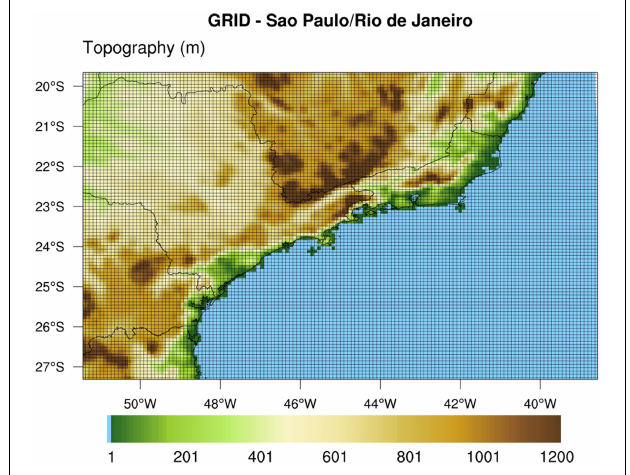
FIGURE 1 | Area considered in the simulations, showing elevations